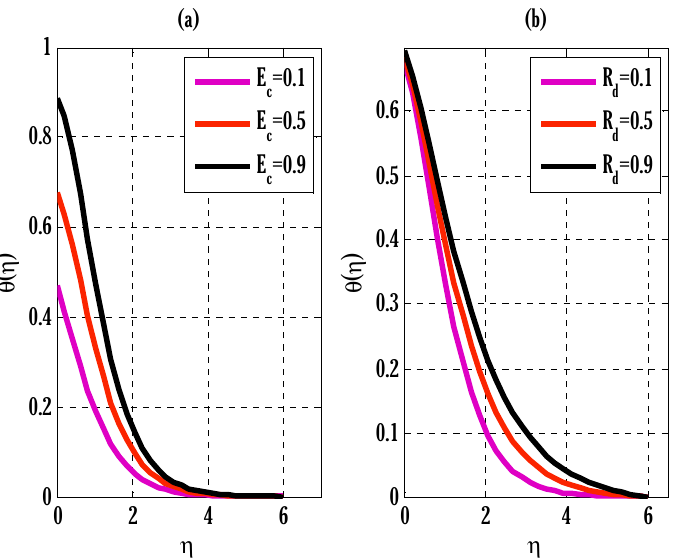
Figure 4. Variation of Eckert number and radiation parameter on temperature profile using N = 30, β = 3, λ = 0.1, F r = 0.1, M = 0.1, E 1 = 0.01, N t = 0.1, N b = 0.1, Bi = 0.5, P r = 1.7, S c = 1.5, and γ = 0.1. ( a ) R d = 0.1, ( b ) E c =